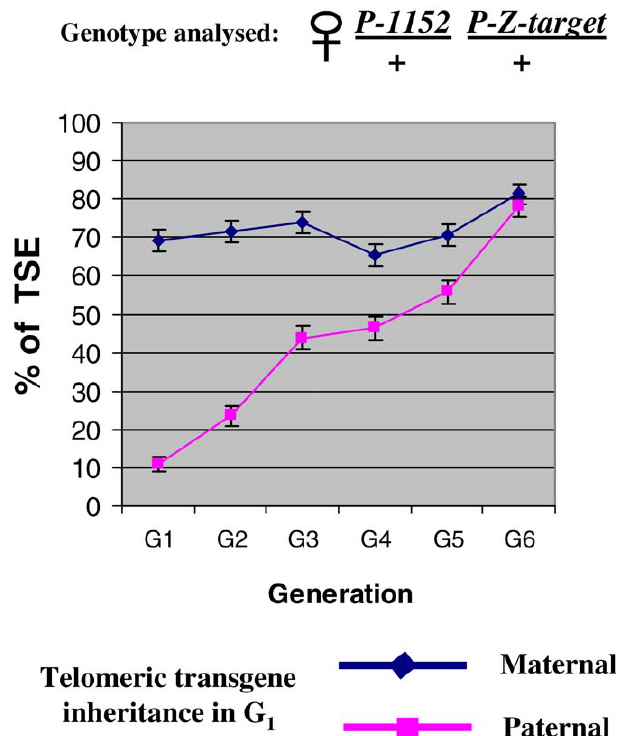
Figure 2. The Level of TSE Is Epigenetically Transmitted through Meiosis Two kinds of G 1 females were generated that carry the telomeric silencer P-1152 and the P-otu-lacZ transgene ( P-Co1 ) used as a TSE target (mating schemes are shown with the complete genotypes on Figure S1). In one lineage, P-1152 was maternally introduced, whereas it was paternally introduced in the other lineage. Because of the maternal effect of TSE, the first lineage (maternal lineage) corresponds to a TSE-positive context in G 1 , whereas the second (paternal lineage) corresponds to a TSE- negative context in G 1 . G 1 females from the two lineages were crossed with P-1152; P-Z-target males to generate in both cases P-1152 / þ ; P-Z- target / þ G 2 females. Thus G 2 females from the maternal and paternal lineages have the same genotype but differ by the cytoplasm inherited in G 1 . This ( P-1152 / þ ; P-Z-target / þ ) genotype was maintained over generations and TSE was measured at each generation. The evolution of TSE is shown in relation to succeeding generations. The blue and pink lines correspond to the lineages in which the P-1152 telomeric silencer locus was maternally and paternally inherited in G 1 , respectively. Confidence intervals of the percentages ( a ¼ 5%) are given.